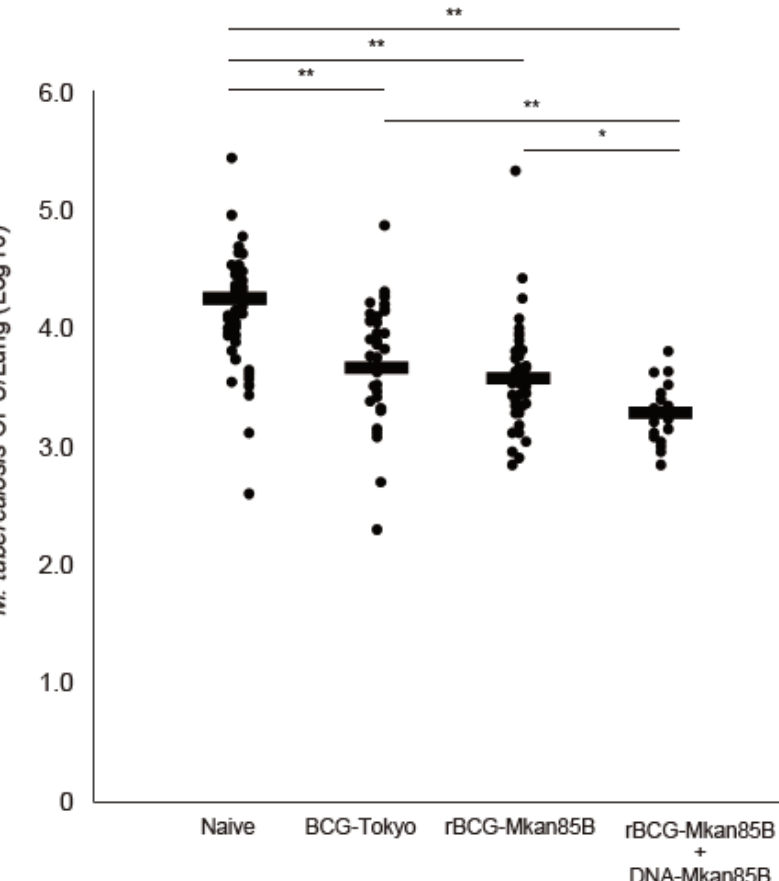
Figure 2. Pulmonary CFUs of unimmunized or immunized with BCG, rBCG-Mkan85B, or rBCG- Mkan85B/DNA-Mkan85B mice 6 weeks after Mtb Erdman challenge. The data represent the results from six independent experiments with six to ten mice per group. The detection limit for bacilli in the tissue homogenate was 15 CFUs. * p < 0.05. ** p < 0.01. To analyze the immune response induced by the vaccines, we also examined the induction of antigen-specific polyfunctional T cells using an intracellular cytokine staining (ICS) method. Immune cells isolated from the lungs and splenocytes were obtained from each mouse infected with Mtb either unvaccinated or vaccinated with BCG-Tokyo, BCG- Mkan85B, or rBCG-Mkan85B/DNA-Mkan85B. The cells were stimulated with 9-mer Ag85B CD8 epitope peptides (Pep8) [1,5] and the 15-mer Ag85B CD4 epitope peptide (peptide 25) [6] in vitro. T cells producing two (IFN- γ +IL-2, IFN- γ +TNF, or IL-2+TNF) or three (IFN- γ +IL-2+TNF) cytokines were defined as polyfunctional T cells. The rBCG- Mkan85B vaccination induced increases in the levels of peptide 25-specific polyfunctional CD4 + T cells in both the lung and spleen (Figure 3A,B). In contrast, Pep8-specific polyfunctional CD8 + T cells were strongly induced only after rBCG-Mkan85B/DNA- Mkan85B prime – boost vaccination (Figure 3A,B).